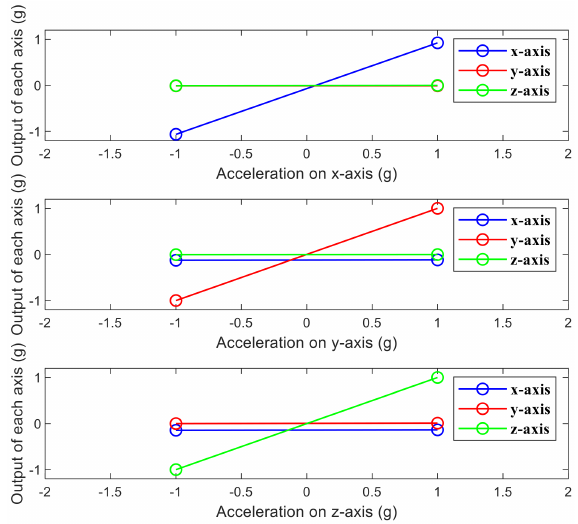
Figure 23. Cross-axis coupling errors test of the tri-axis accelerometer.